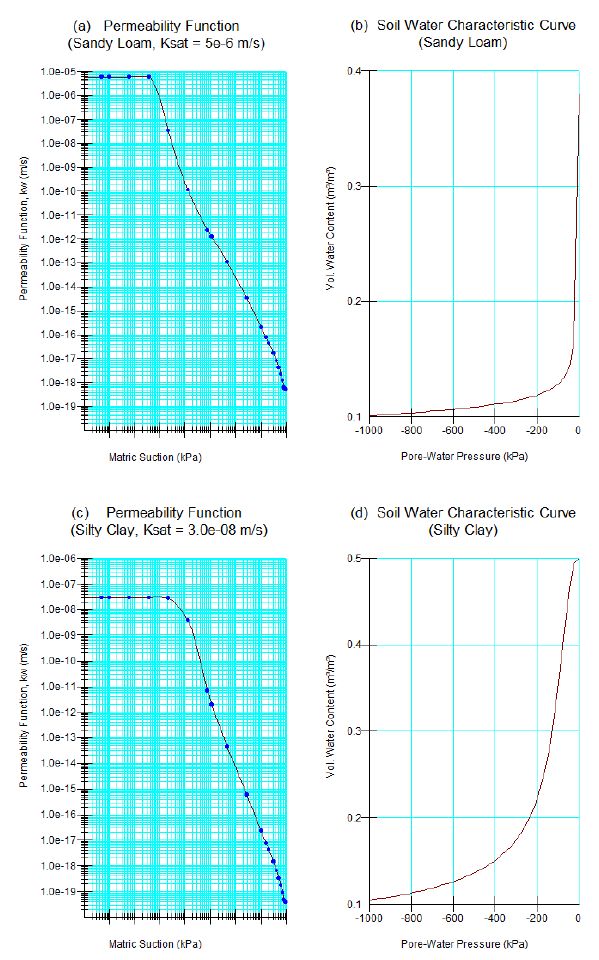
Fig. 13. Unsaturated permeability function and soil water character- istic curve assigned to debris cover assimilated to a sandy loam ( a and b ) and to Werfen deposits assimilated to a silty-clay ( c and d ).